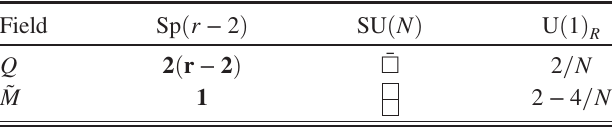
TABLE I. Quantum numbers of fields when N is even.